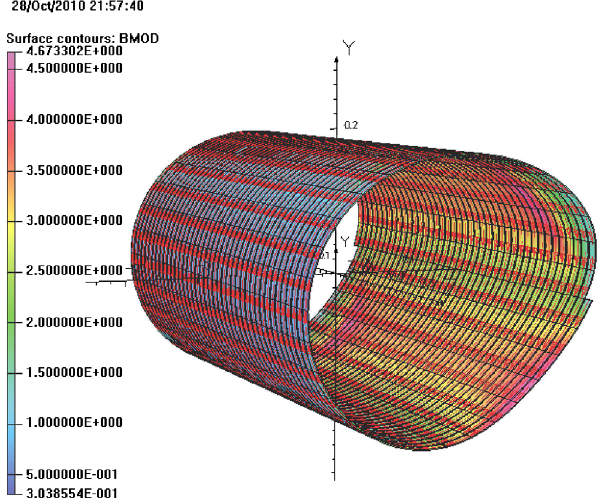
FIG. 20. Peak magnetic field on the wire of the D magnet for the carbon ring for the 4th layer from the